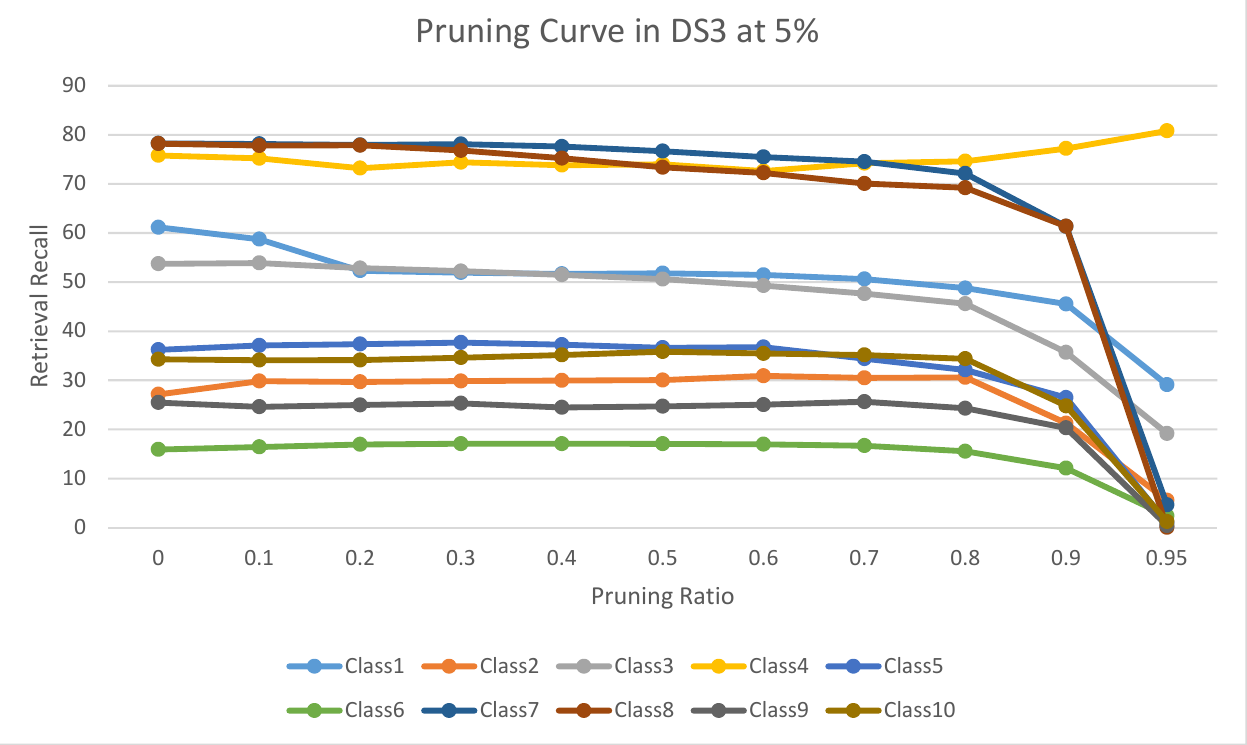
Figure 9. The level of retrieval recall values at different percentages of pruning at the top 5% in DR3-MDDR.